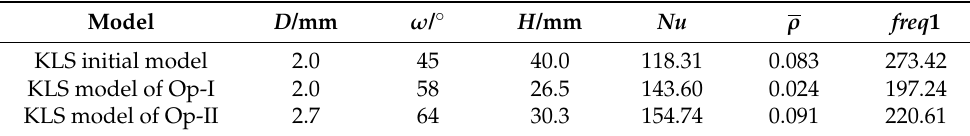
Table 9. Comparison of initial model the optimal model of